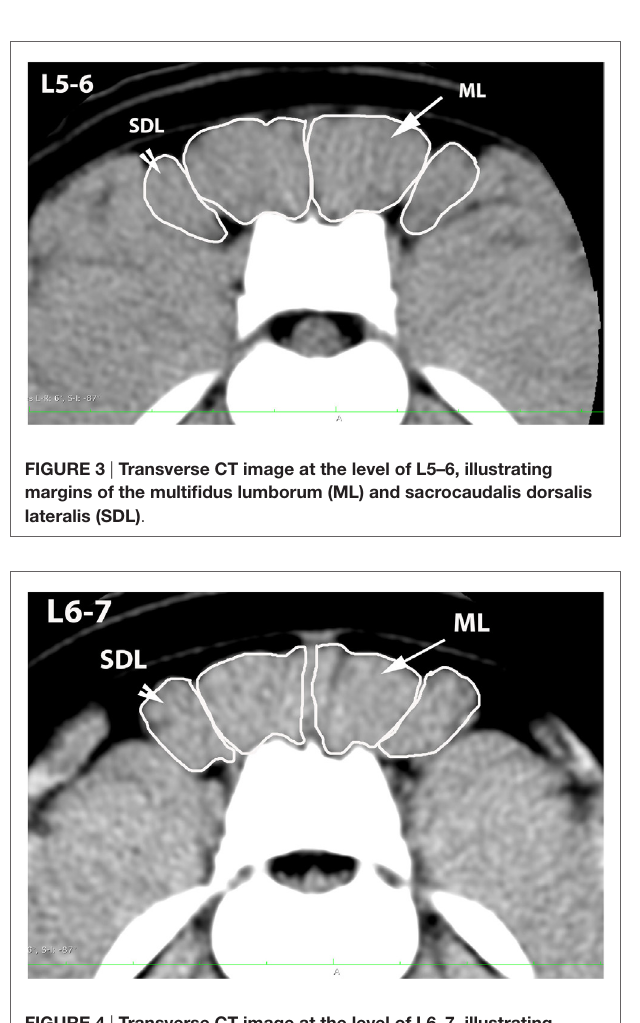
FIGURe 4 | transverse Ct image at the level of L6–7, illustrating margins of the multifidus lumborum (ML) and sacrocaudalis dorsalis lateralis (sdL) .